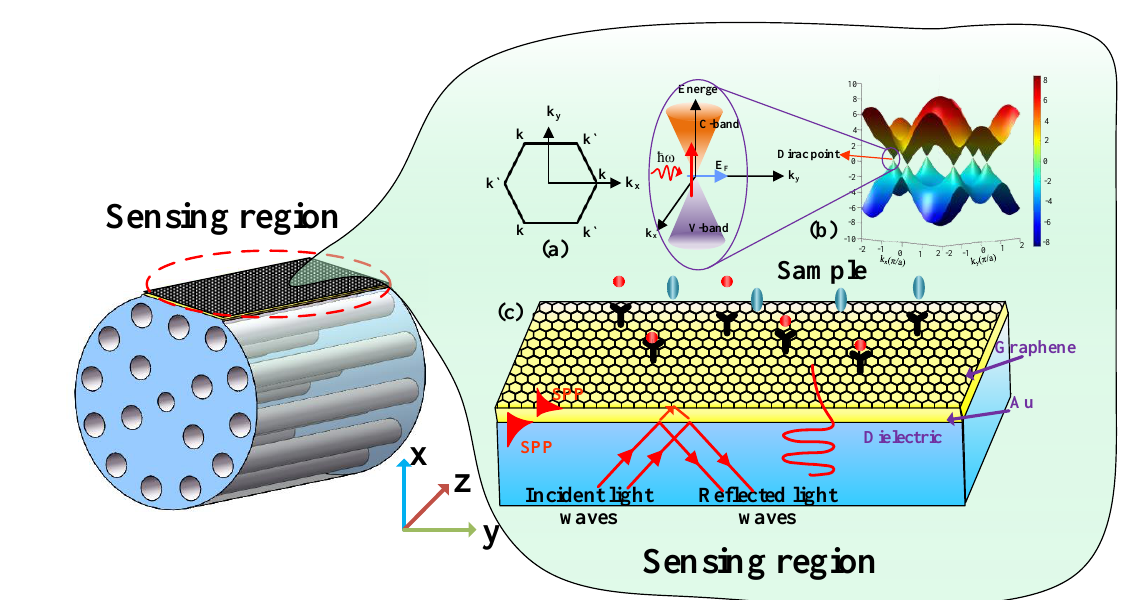
Figure 1. Surface plasmon resonance (SPR) sensing mechanism of D-type photonic crystal fiber (PCF) sensor. ( a ) The Brillouin zone of the graphene lattice. ( b ) Linear dispersion diagram of the band structure of single-layer graphene. ( c ) Schematic diagram of Graphene-Au sensing mechanism.